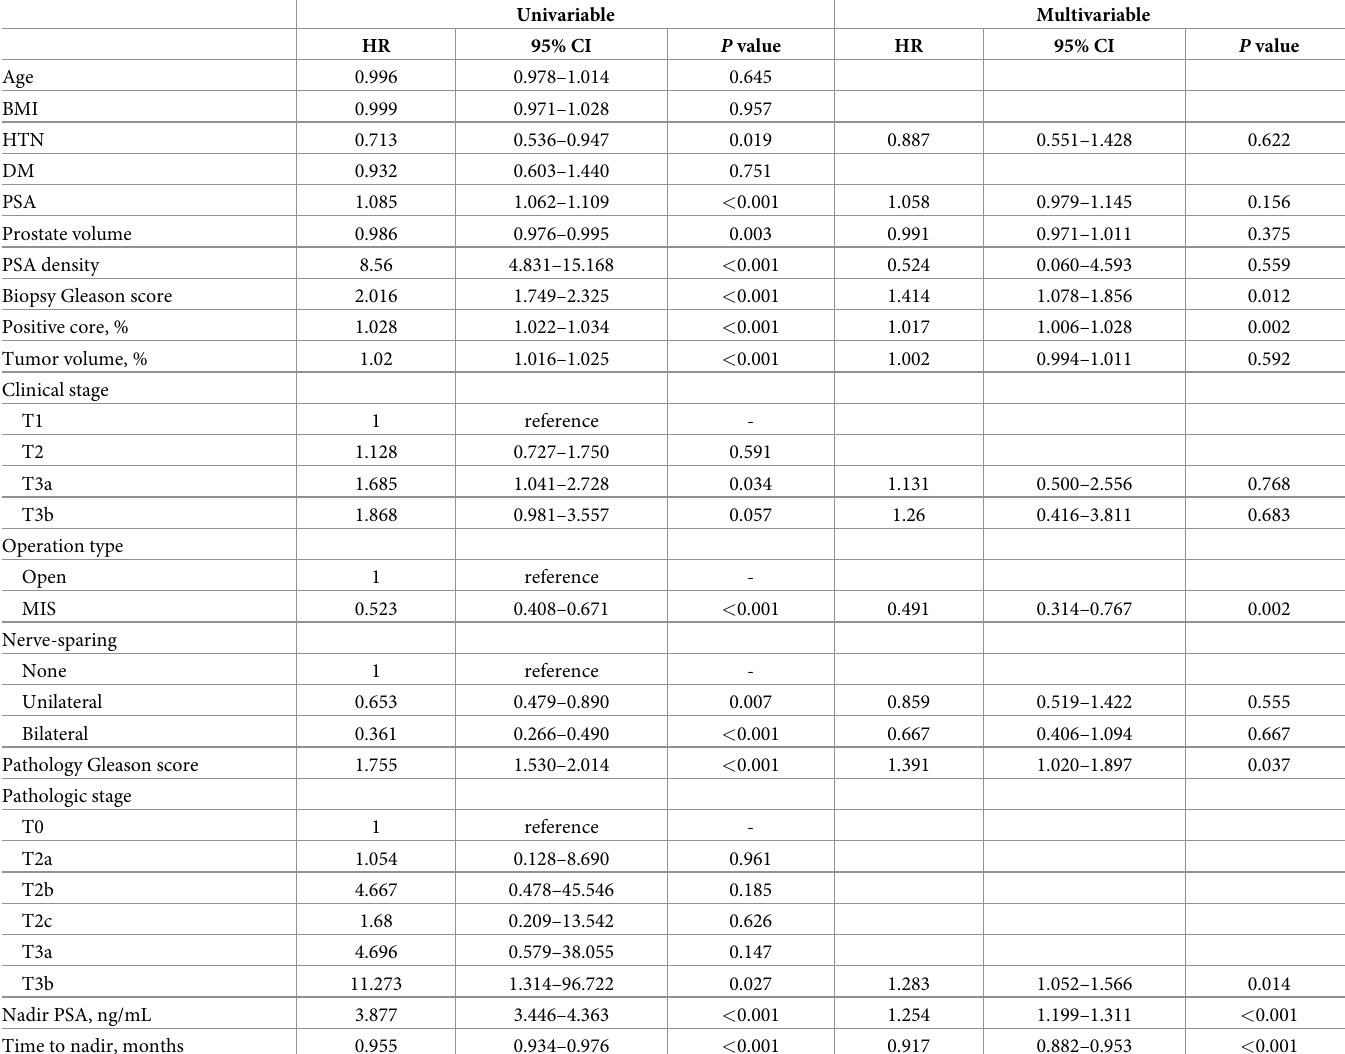
Table 3. Univariable and multivariable Cox regression analyses of biochemical